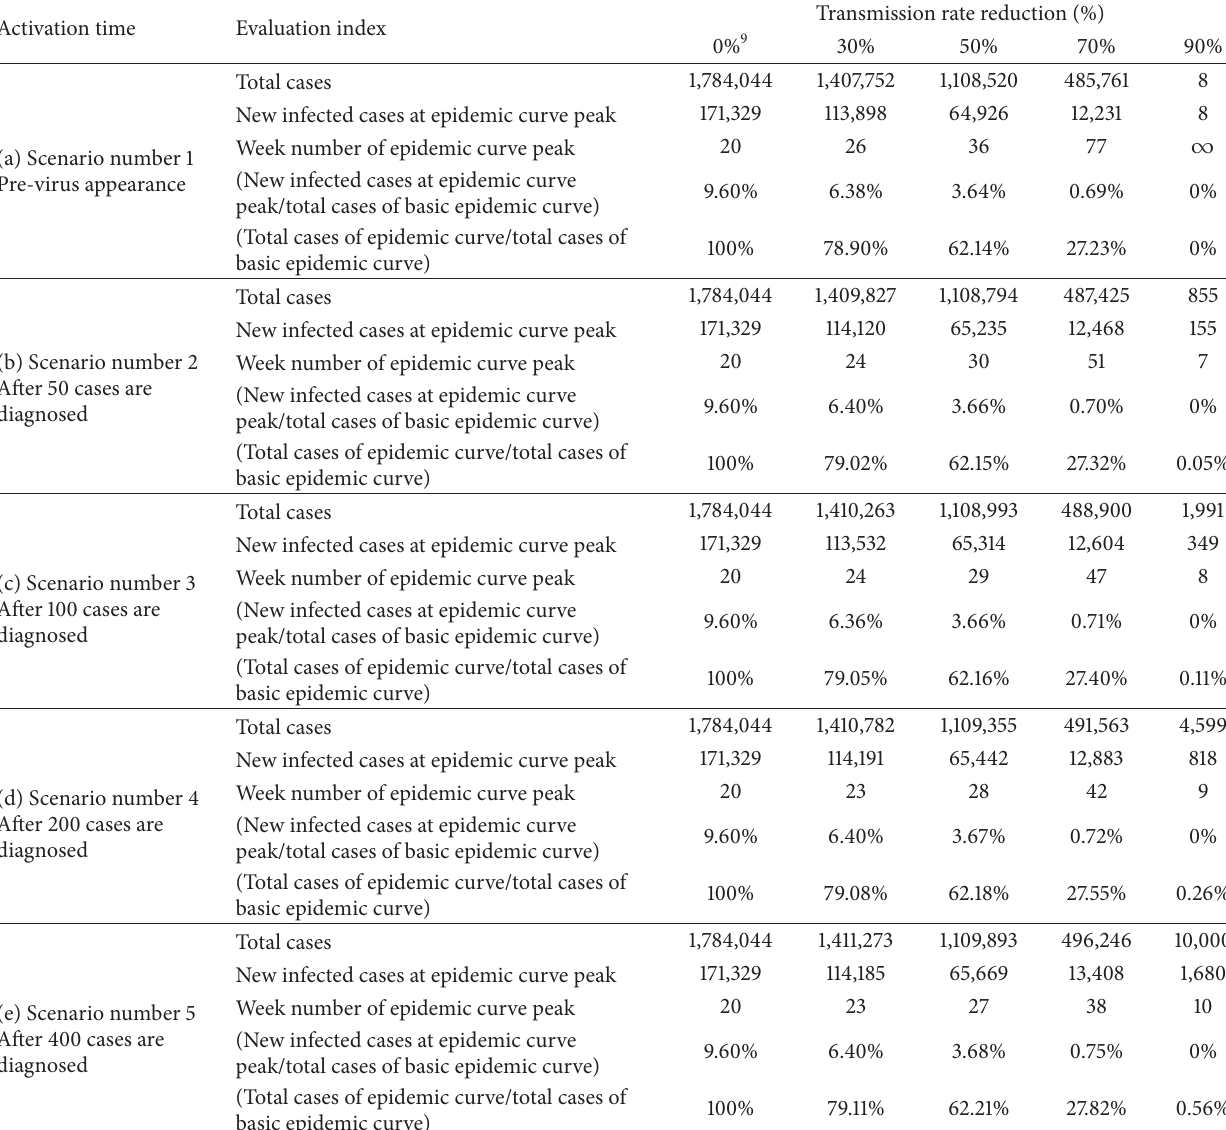
Table 2: Observation index values according to different policy activation scenarios duringswine-origin H1N1 influenza Aoutbreak in Taipei. Activation